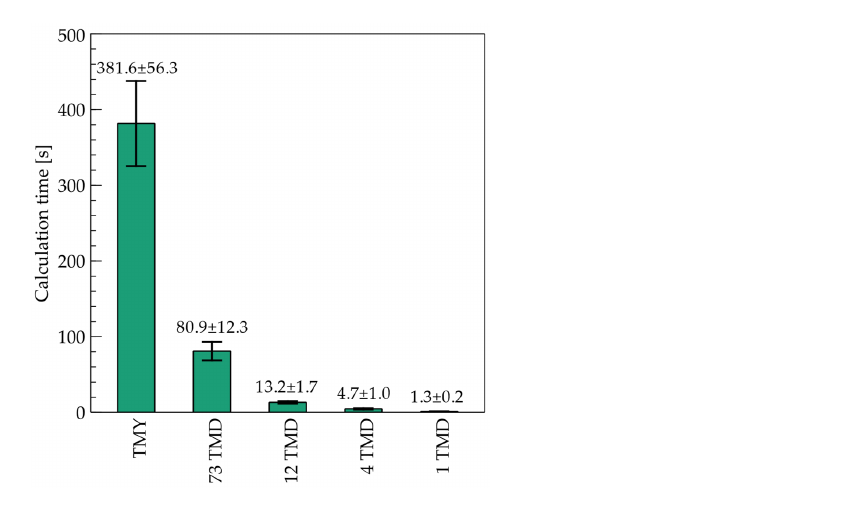
Figure 4. Normalized mean absolute errors of produced electricity for each year of a historic weather data set.